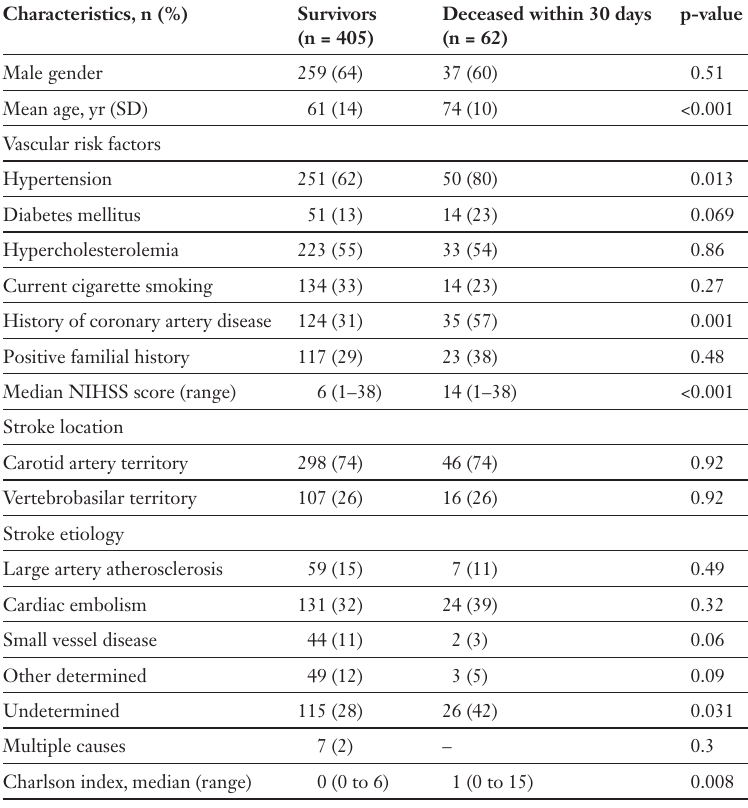
Presenting clinical characteristics of 467 patients with a first-ever ischaemic stroke. Characteristics, n (%)